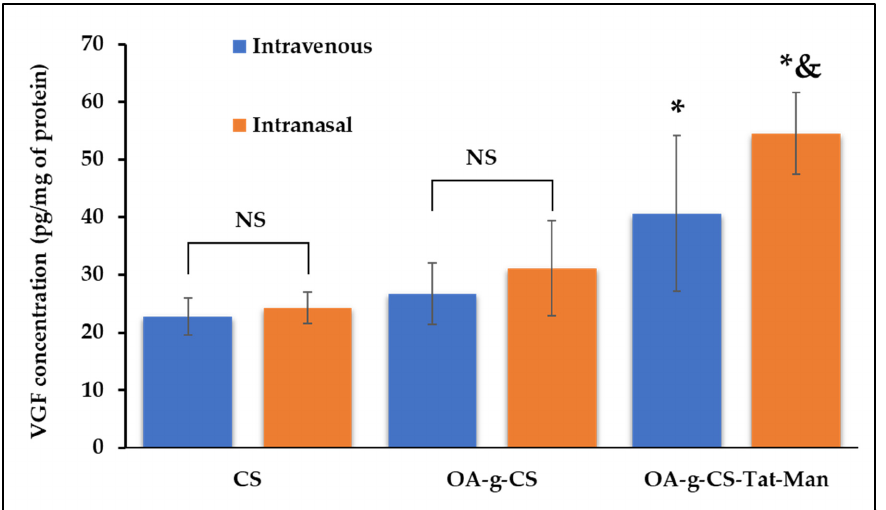
Figure 10. In-vivo VGF expression after treating C75BI/6 J mice with CS–pVGF, OA-g-CS–pVGF, and OA-g-CS-Man-Tat–pVGF polyplexes using the intranasal and intravenous route. Results are presented as mean ± SD ( n = 6). (“*” indicates significantly ( p < 0.05) different from intravenous CS “&” indicates significantly ( p < 0.05) different from intravenous OA-g-CS-Man-Tat–pVGF). NS represents non significance.